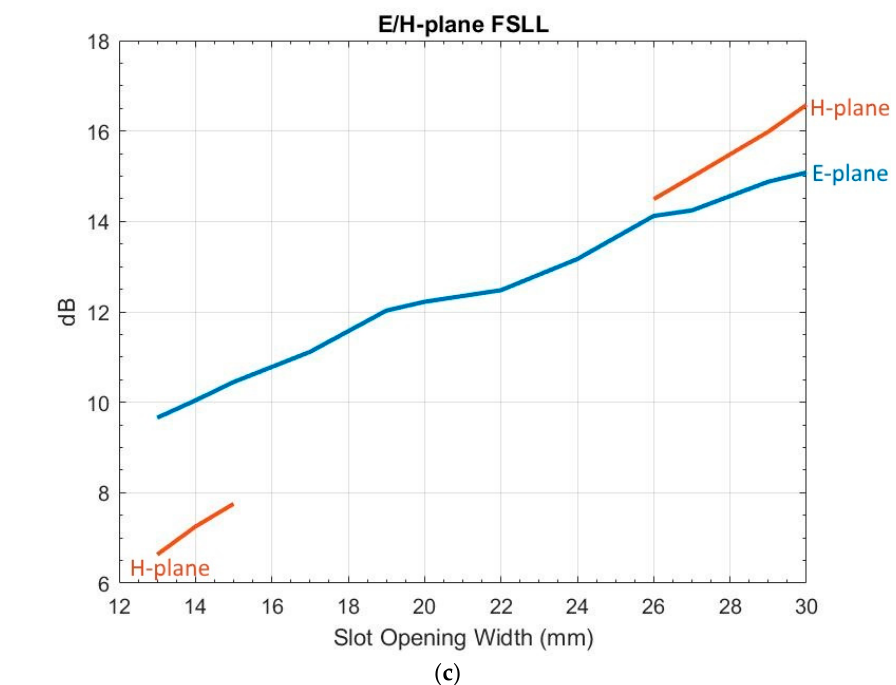
Figure 4. Variation of slot opening width: ( a ) peak S11 of low, mid, high, and ultra bands (blue: low, red: mid, yellow: high, purple: ultra); ( b ) E/H-plane gain, HPBW (in degree) (blue solid: E-plane gain, blue dash: H-plane gain, red solid: E-plane HPBW, red dash: H-plane HPBW); and ( c ) E-plane and H-plane FSLL (blue: E-plane, red: H-plane). Note: The discontinuity on the H-plane FSLL resulted from no detectable front side lobe peak.